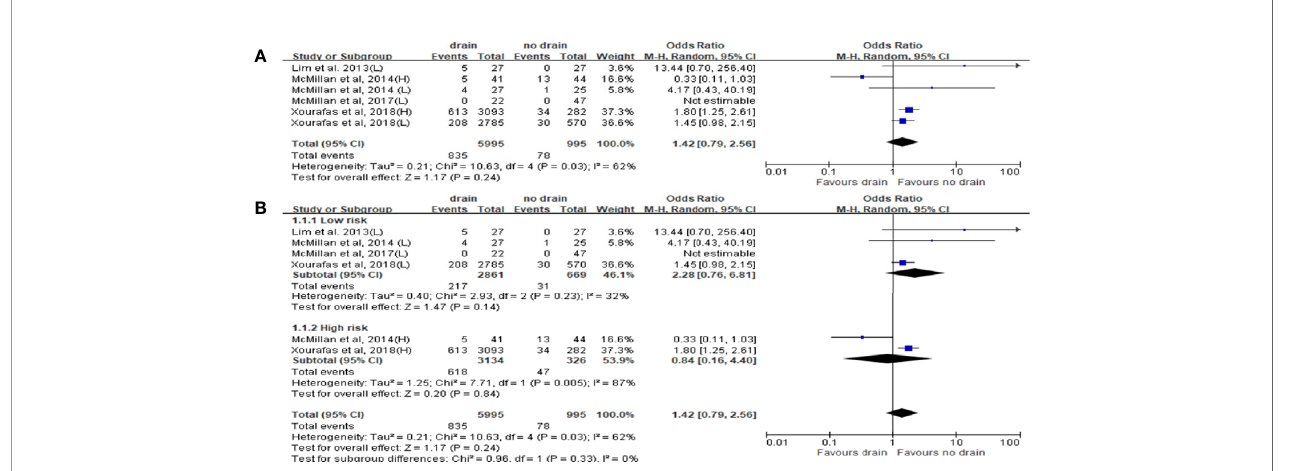
FIGURE 6 | Forest plot of the comparison of the rate of CR-POPF in drain versus no-drain groups after pancreatic resection. (A) Comparison in overall; (B) comparison in Low risk and High risk subgroups, respectively.